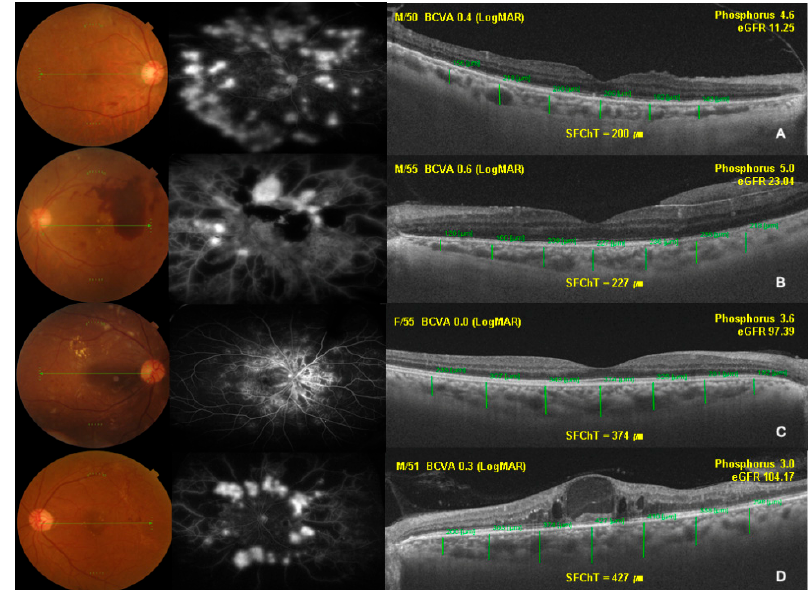
Figure 1. Representative cases showing choroidal thinning and thickening in treatment-naïve eyes of patients with proliferative diabetic retinopathy (PDR). Patients with thinner choroids ( A,B ) exhibited a more advanced stage of chronic kidney disease (CKD) than those with thicker choroids ( C,D ). BCVA, best-corrected visual acuity; LogMAR, logarithm of the minimum angle of resolution; eGFR, estimated glomerular filtration rate.